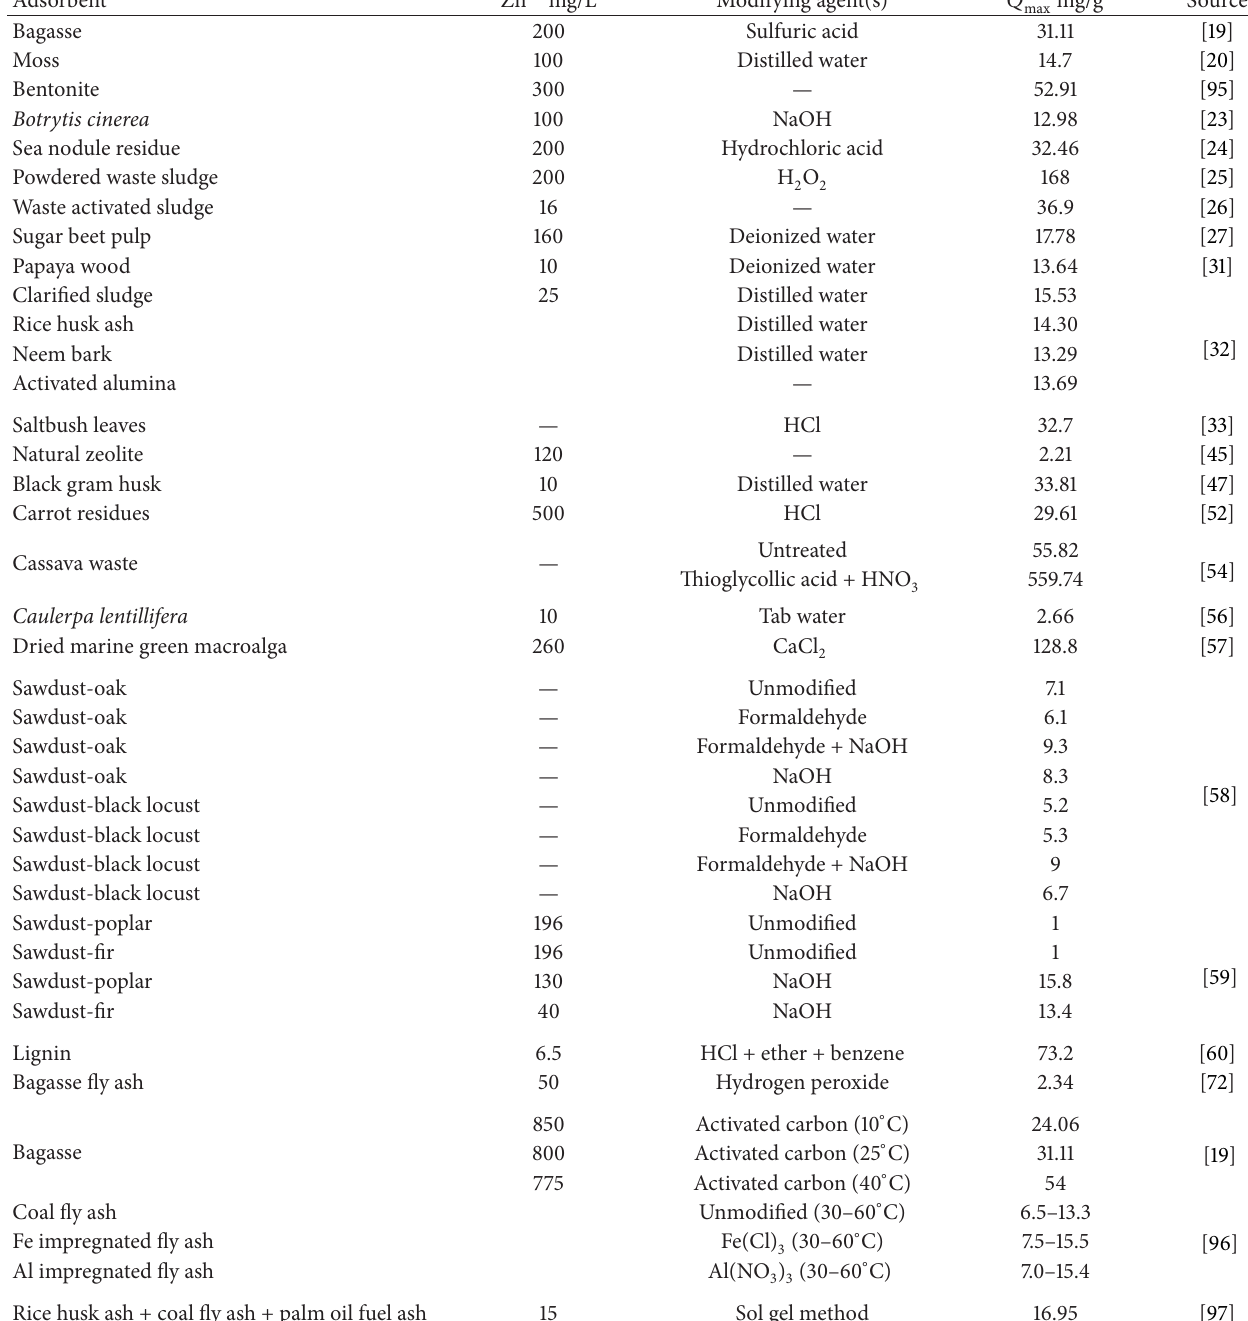
Table 3: Adsorption capacities of different adsorbents for the removal of Zn 2+ from